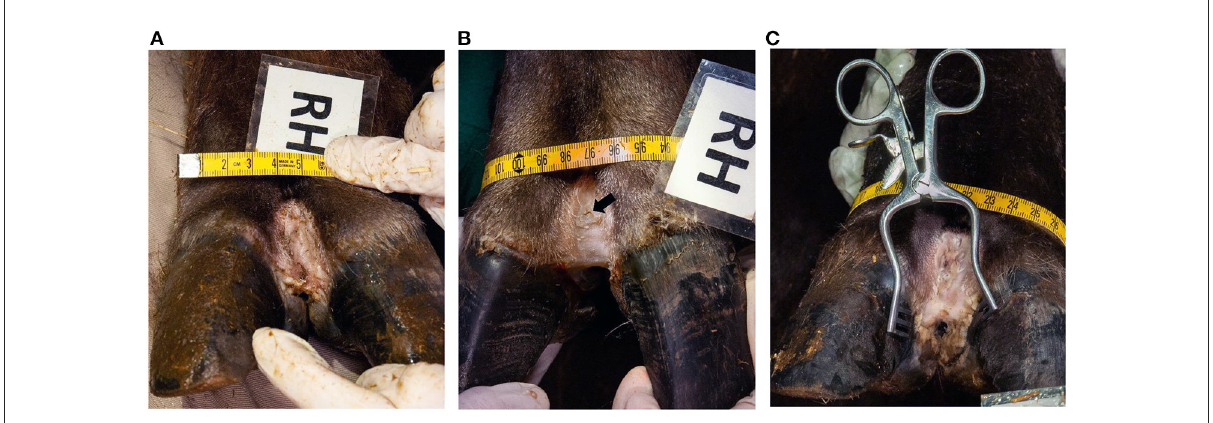
FIGURE2 Clinical appearance of dorsal interdigital cleft of the right hind foot (RH) of animal No. 4. (A) Before treatment (macroscopical score 2/2), (B) after treatment (macroscopical score 0/0) (the arrow shows the biopsy site B1, taken before treatment), (C) and 2 months after treatment (macroscopical score